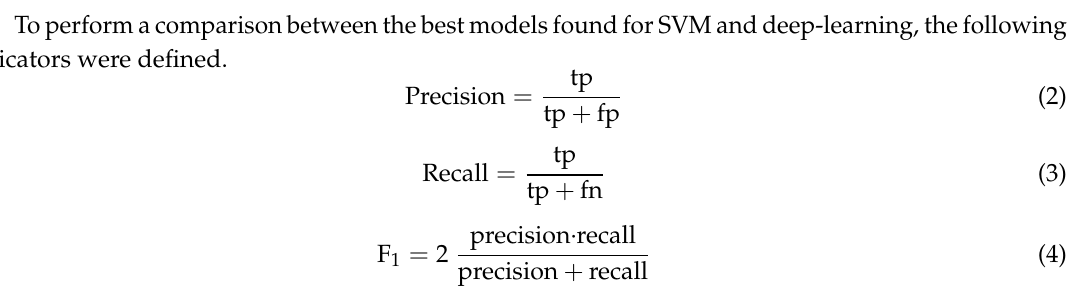
Figure 6. Deep-learning test accuracy vs. number of training images .